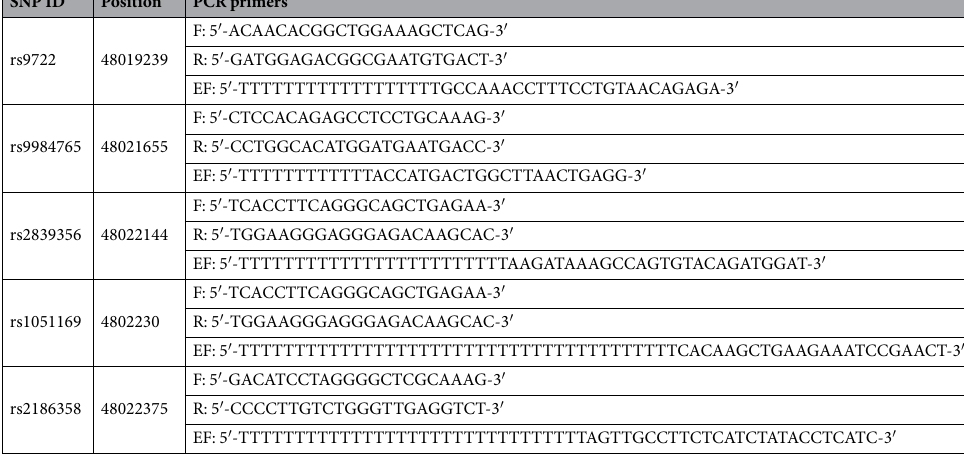
Table 5. The primer sequences used for detecting five SNPs of the S100B gene. F: forward primer; R: reverse primer; EF: Extended